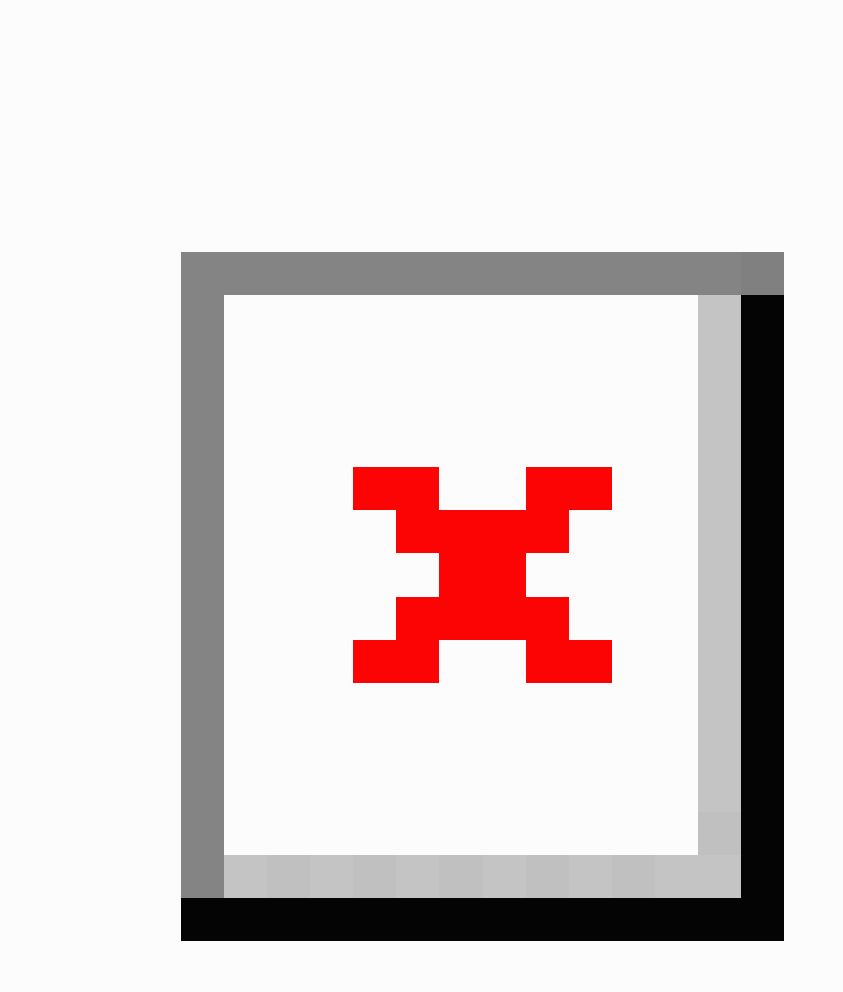
Figure 7. Comparison between the numbers of unique places detected from sensor data and reported by study participants in logsheets.